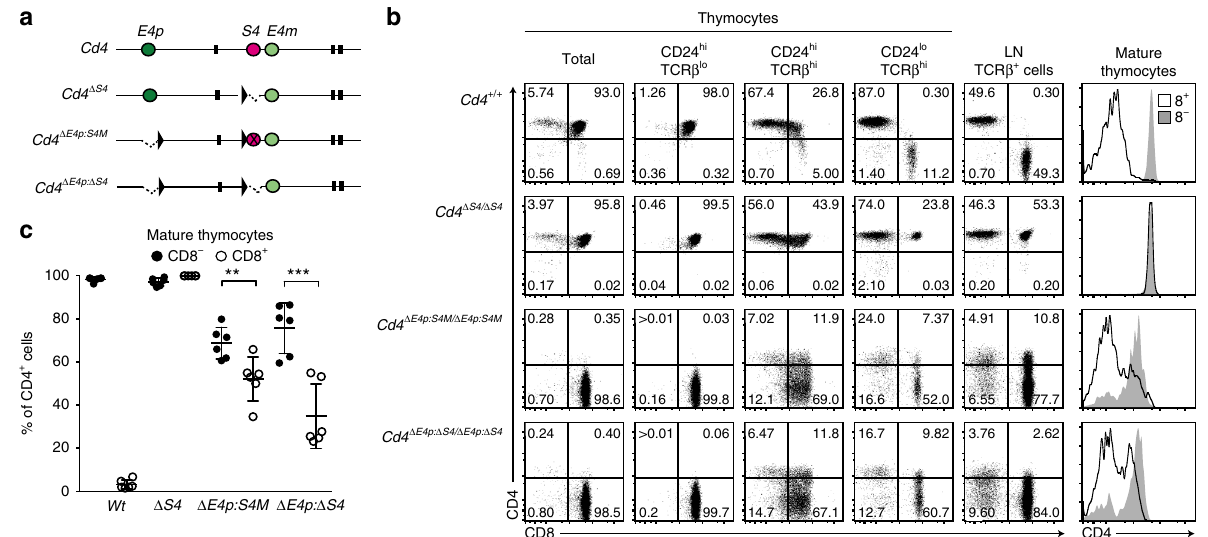
Fig. 5 Helper-lineage dominant activity of E4m . a Schematic structures of Cd4 , Cd4 Δ S4 , Cd4 Δ E4p:S4M , and Cd4 Δ E4p: Δ S4 alleles are shown as in Fig. 2a. Mutations at two Runx sites within S4 are marked as X in the Cd4 Δ E4p:S4M allele. b Dot plots showing CD4 and CD8 expression in indicated thymocyte subsets of mice with indicated genotypes. Numbers in quadrants indicate respective cell percentages. Right histograms showing CD4 expression in CD8 + and CD8 − mature (CD24 lo TCR β hi ) thymocyte populations. Representative results of at least fi ve independent analyses. c Summary of percentage of CD4 + cells in CD8 − and CD8 + mature (CD24 lo TCR β hi ) thymocyte populations of Cd4 + / + ( Wt ), Cd4 Δ S4/ Δ S4 ( Δ S4 ), Cd4 Δ E4p:S4M/ Δ E4p:S4M ( Δ E4p:S4M ),